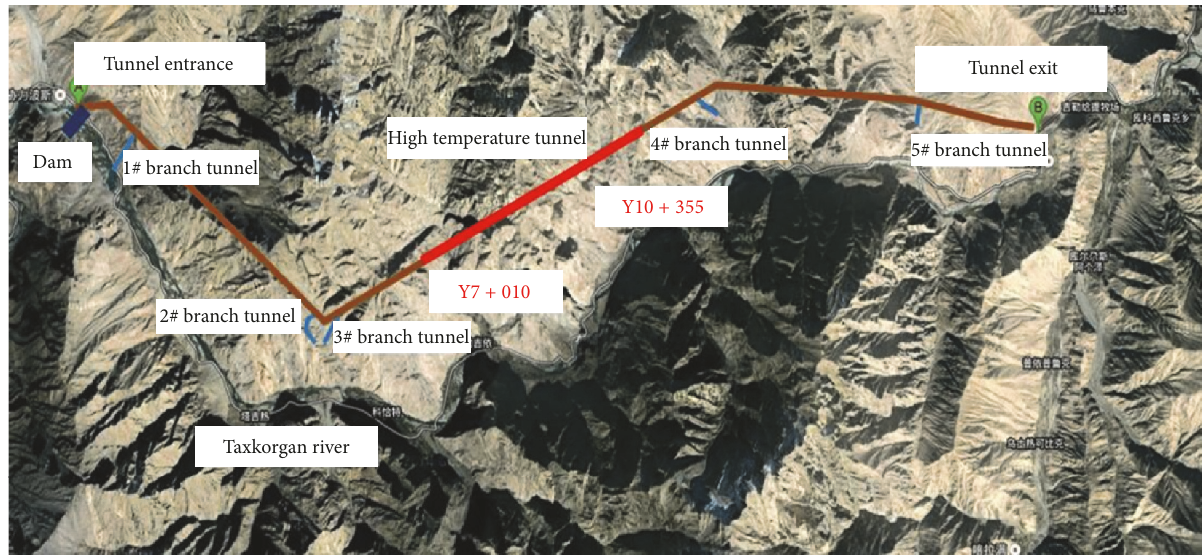
Figure 1: Diversion tunnel layout